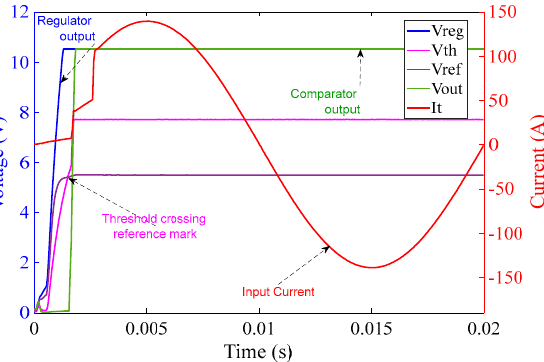
Figure 16. 10 Ω burden circuit operation at 100 A(rms) input current over 20 ms. Figure 16. 10 Ω burden circuit operation at 100 A (rms) input current over 20